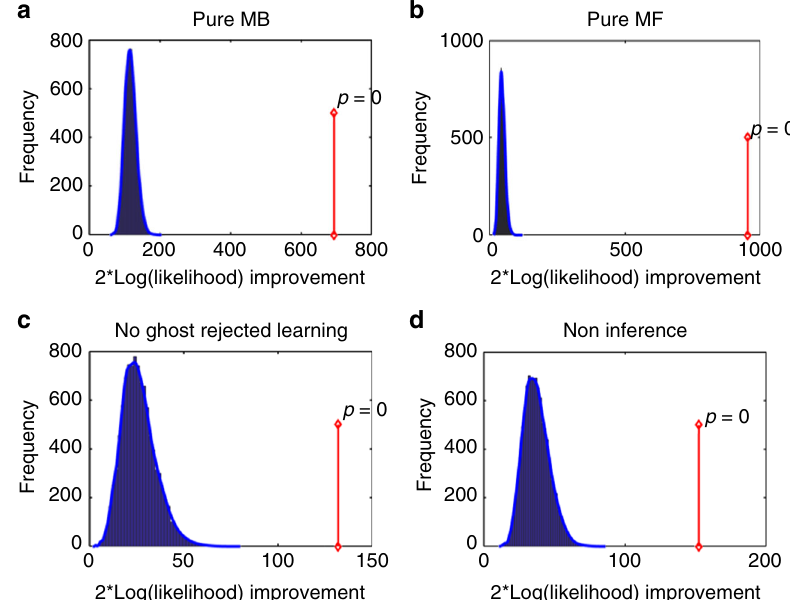
Fig. 5 Model-comparison results. a Results of the bootstrap-GLRT model-comparison for the pure MB sub-model. The blue bars show the histogram of the group twice log-likelihood improvement (model vs. sub-model) for synthetic data that was simulated using the sub-model (10001 simulations). The blue line displays the smoothed null distribution (using Matlab ’ s “ ksdensity ” ). The red line shows the empirical group twice log-likelihood improvement. Zero out of the 10001 simulations yielded an improvement in likelihood that was at least as large as the empirical improvement. Thus, the sub-model can be rejected with p < 0.001. b Same as a , but for the pure MF-action sub-model. This sub-model was rejected with p < 0.001. c Same as a but for the no learning for ghost-rejected sub-model, p < 0.001. d Same as a but for the non-inference sub-model, p < 0.001